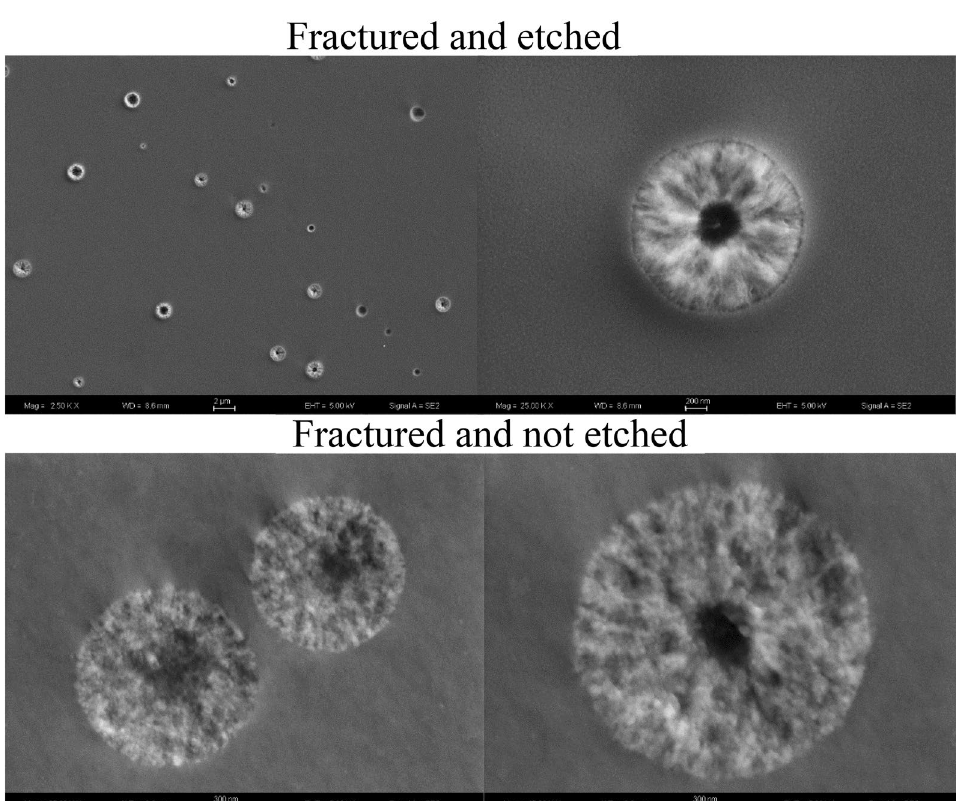
Figure 7. SEM images of the 5–8 glass sample nucleated at 780 °C for two hours. The upper two side by side images are for the fractured and etched surface. The lower two images are the fractured and not etched